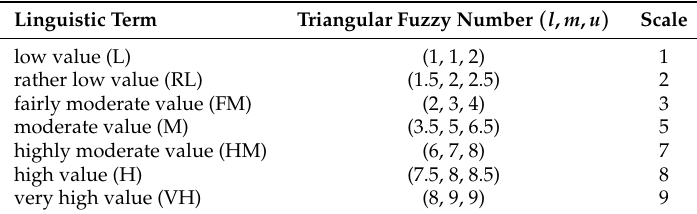
Table 7. Fuzzy rating in the evaluation process.